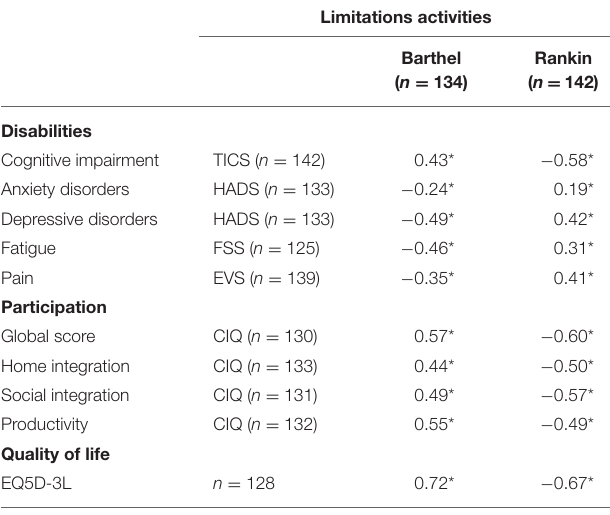
TABLE 3 | Spearman correlation coefficients between F-TICS-m, EVS, HADS, FSS, or EQ5D-3L scores and either mRS or BI